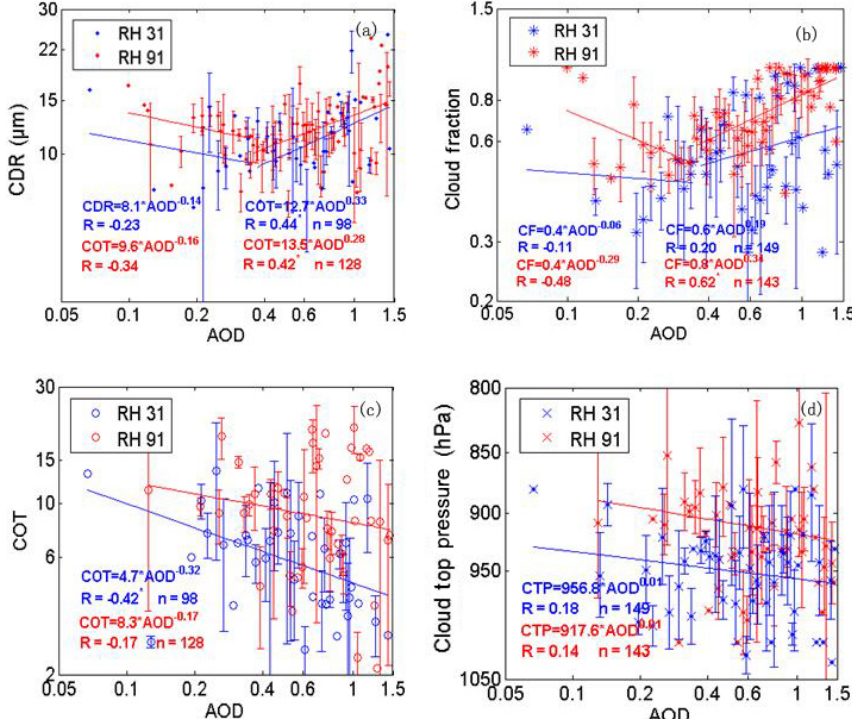
Figure 9. Scatter plots of cloud parameters versus AOD over YRD on log–log scale for cases of low relative humidity (31%) condition (blue) and mixed aerosol–cloud layers under high relative humidity (91%) condition (red): (a) CDR, (b) CF, (c) COT and (d) CTP. The lines present the least-square fits, and the resulting relations are presented in each figure. The error bars indicate the statistical uncertainties as in Fig.